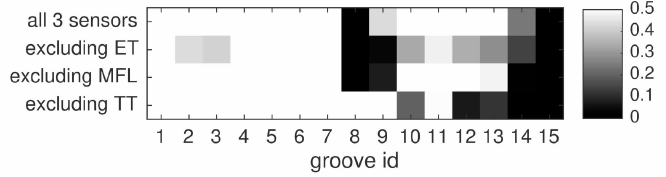
Figure 14. Influence of individual sensors on the fusion result, for the median fusion rule and a fixed kernel